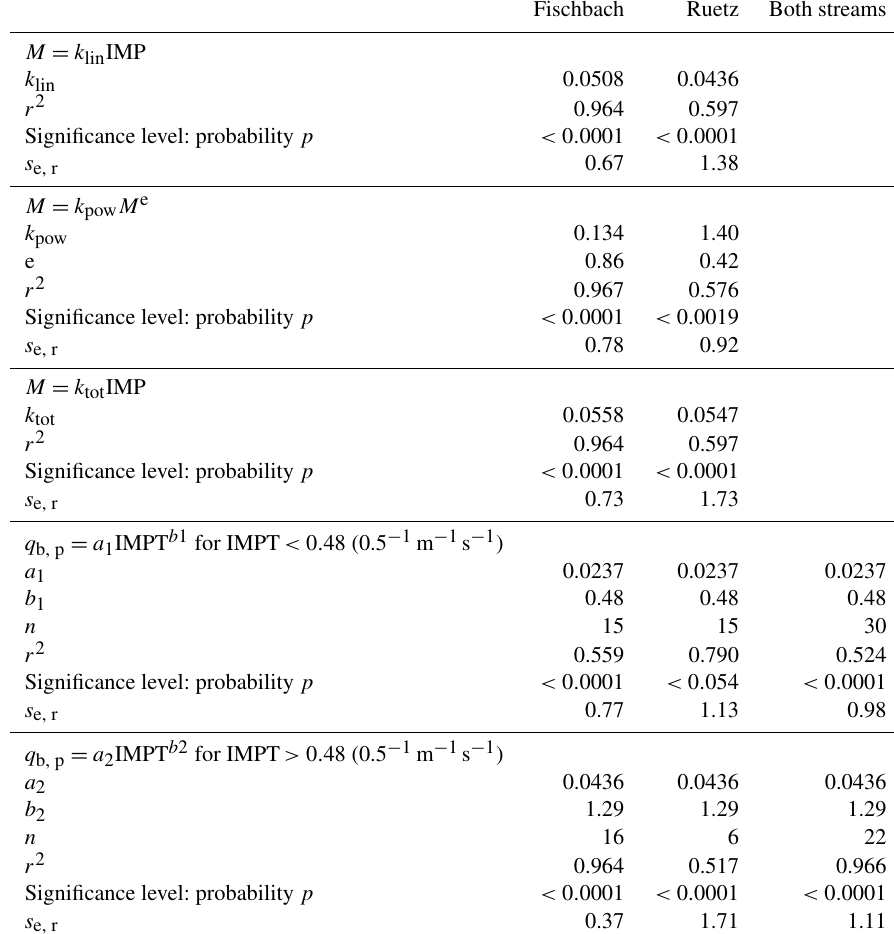
Table 3. Coefficients, exponents and statistical properties for the calibration relations according to Eqs. (1)–(5). All calibration relations refer to bedload mass with D > 10mm, or unit bedload transport rate q b, p for D > 10mm. In the equations, the units are M (kg), q b, p (kg0.5 − 1 m − 1 s − 1 ), and IMPT (1 0.5 − 1 m − 1 s − 1 ). Here r 2 is the correlation coefficient between values calculated with the